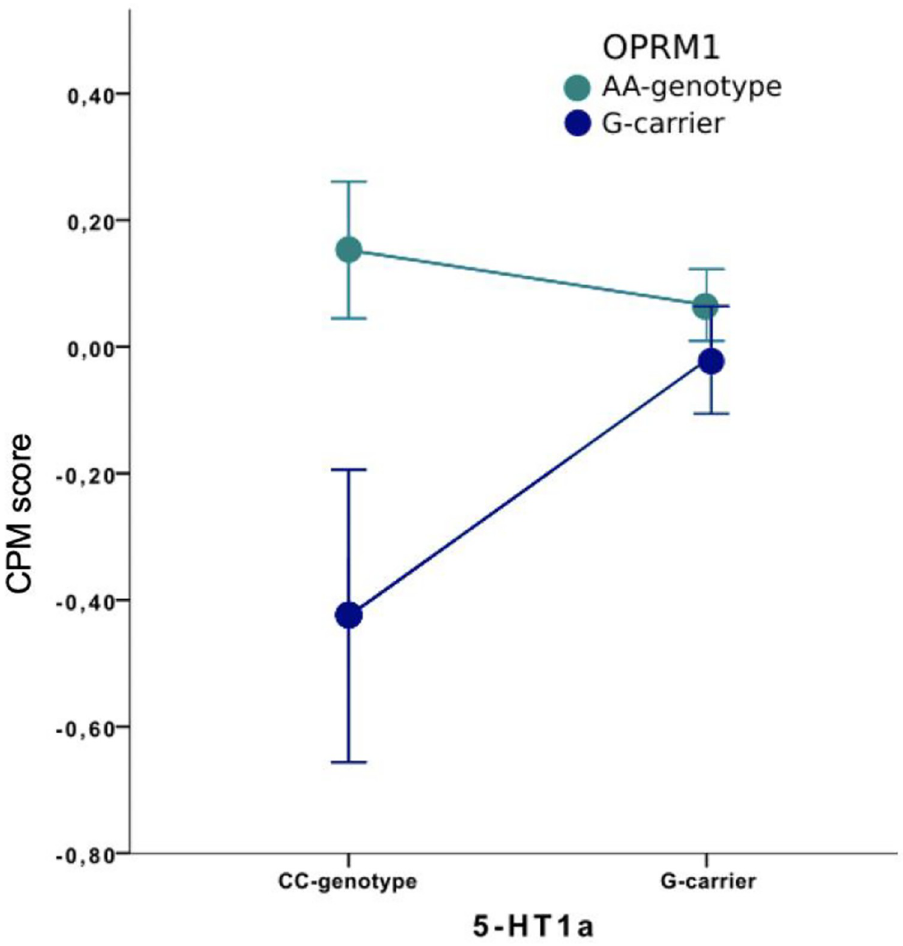
Fig 3. Genetic interaction of OPRM1 and 5-HT1a. A significant gene-to-gene interaction between OPRM1 and 5-HT1a was found on conditioned pain modulation (CPM) in fibromyalgia (FM) and healthy controls. Subjects with 5-HT1a CC-genotype had a significantly higher CPM score if they also had the OPRM1 AA-genotype compared to G- genotype (p < 0.05). In accordance, there was a trend in OPRM1 G-carriers where 5-HT1a G-carriers had a higher CPM score than CC-carriers (p = 0.065). PPT = pressure pain threshold. CPM score = (PPT end–PPT baseline)/PPT